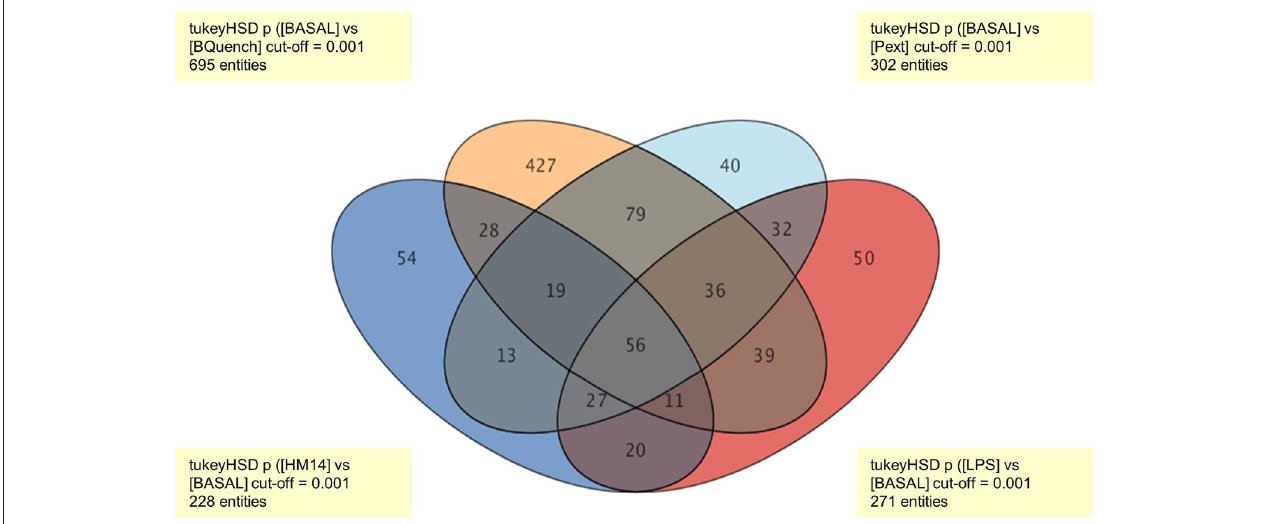
FIGURE 3 | Venn diagram representing all relationships between the four groups (Pext, HM14, LPS, and Blank) in comparison to Basal conditions. The number of entities responsible for the differences between treatment groups and control were 302 for Pext, 228 for HM14 and 271 for